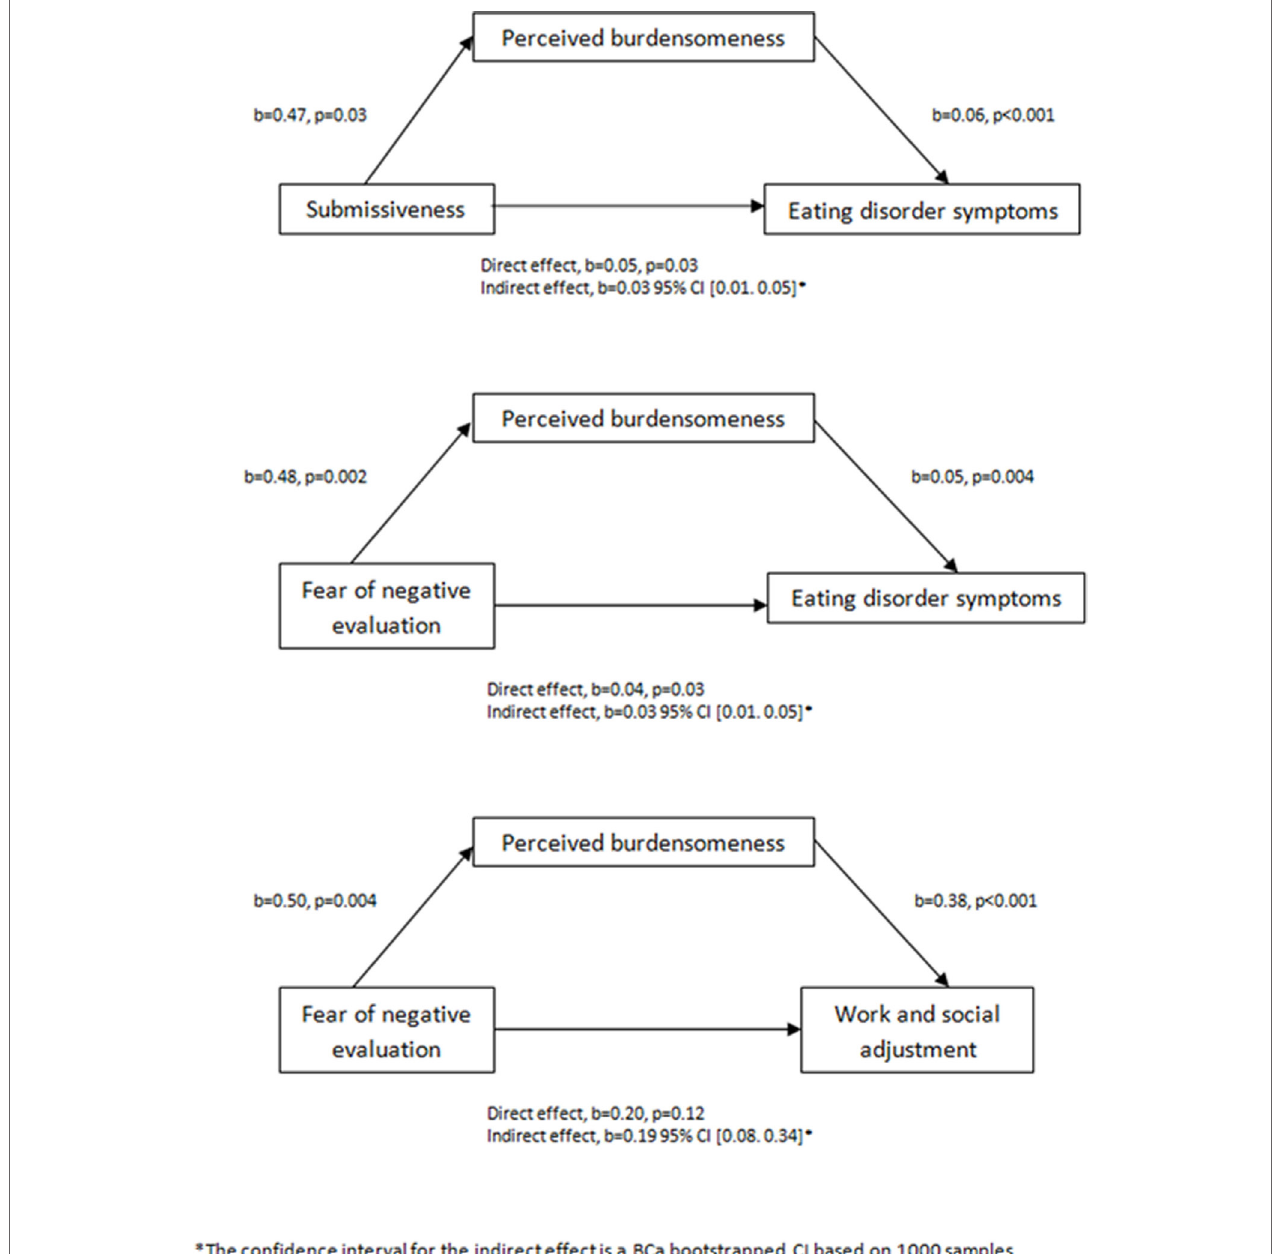
FigUre 1 | Three mediation models of early life experiences of submissiveness (ELES-Submissiveness) and fear of negative evaluation (BFNES) as predictors of eating disorder symptoms (EDE-Q) and of work and social adjustment (WSAS), mediated by perceived burdensomeness